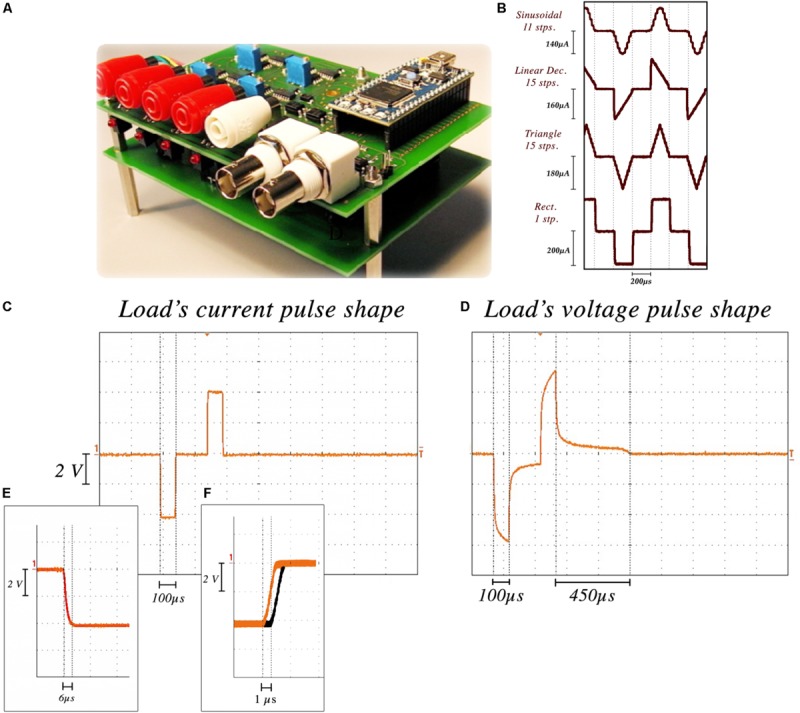
NES STiM characterization. (A) the NES STiM system. (B) Comparison between sinusoidal (11 steps), linear decreasing (15 steps), triangle (15 steps), and standard rectangular (1 step) pulses. (C) Current pulse measured from an 80 W resistor placed in series with the electrode. (D) Electrode potential of the same pulse, showing the duration of the passive charge balancing required for the potential to reach the pre-pulse value. (E) Rise and fall time of each step ≈6 μs. (F) The latency between first and last channel outputs.